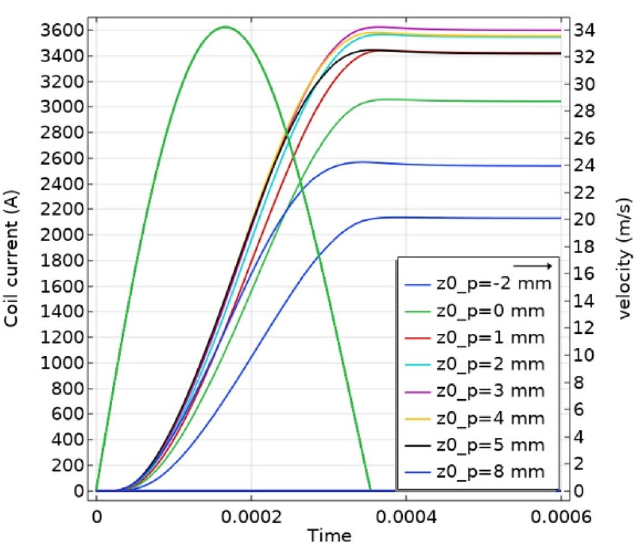
Figure 6. First stage simulation results, a parameter sweep of the optimal initial position